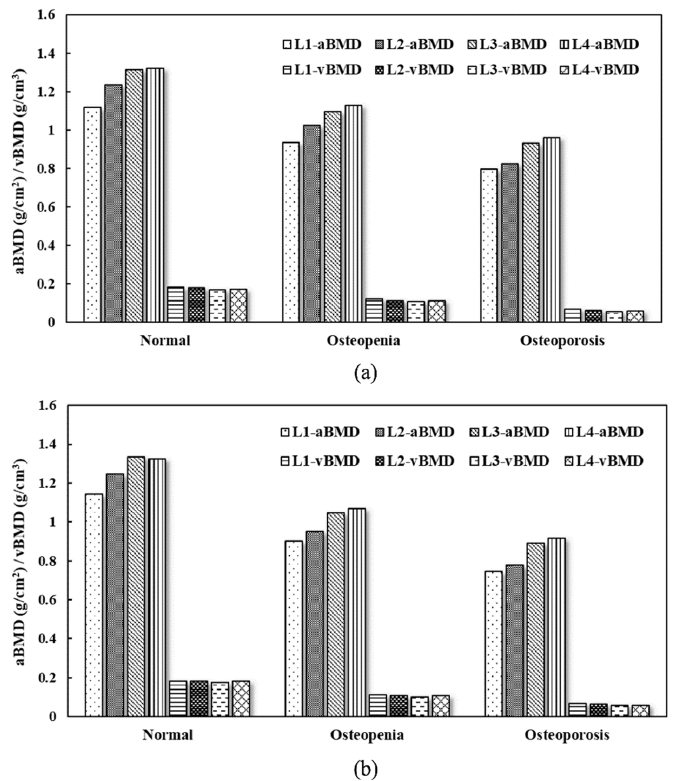
Figure 4. Bar graphs of aBMD (g/cm 2 ) and vBMD (g/cm 3 ) in the ( a ) experimental and ( b ) test cohorts. The aBMD and vBMD of the normal subjects are greater than those in the osteopenia and osteoporosis groups. Table 1. Basic information, aBMD, and T -score of three different groups in the experimental and test cohorts. Experimental